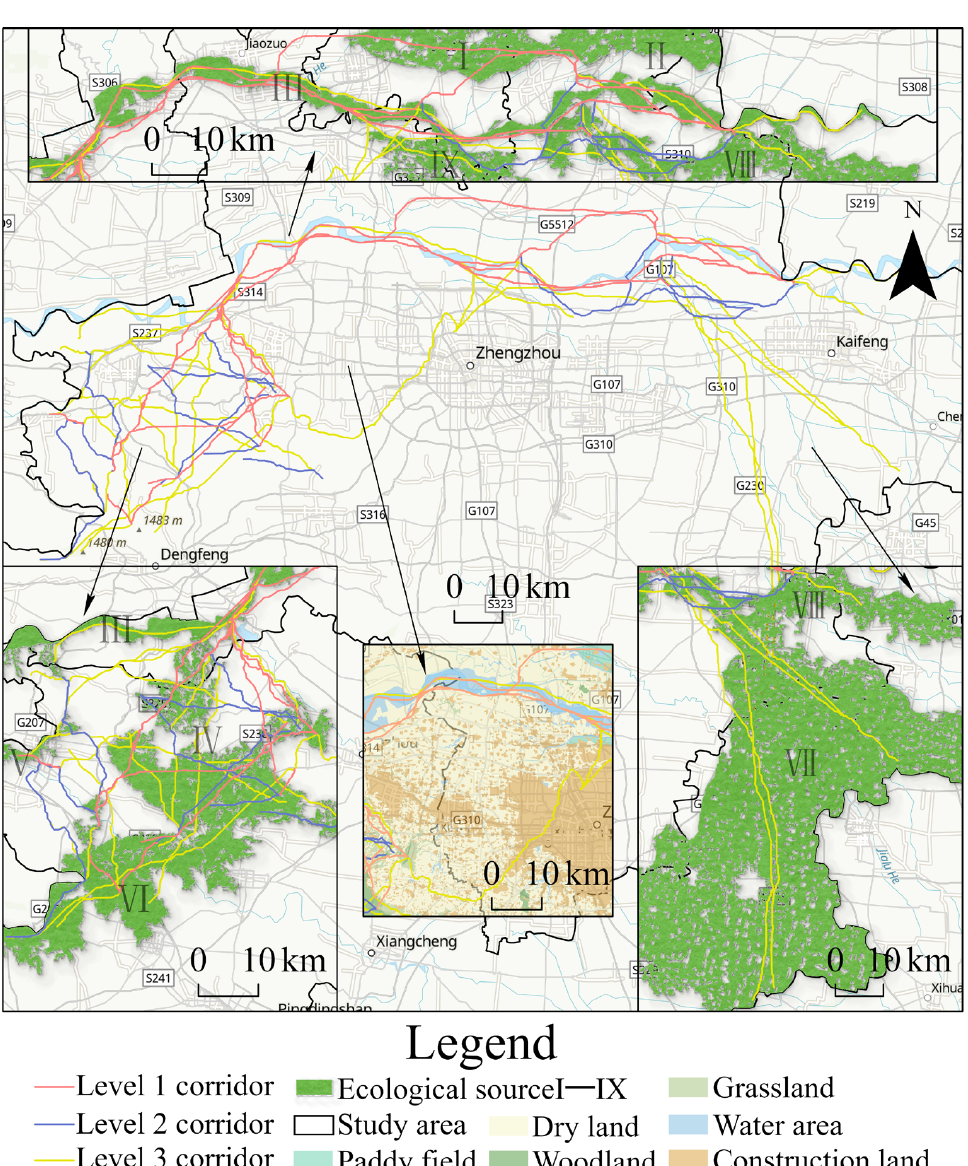
Figure 7. Extraction and classification of ecological corridors.